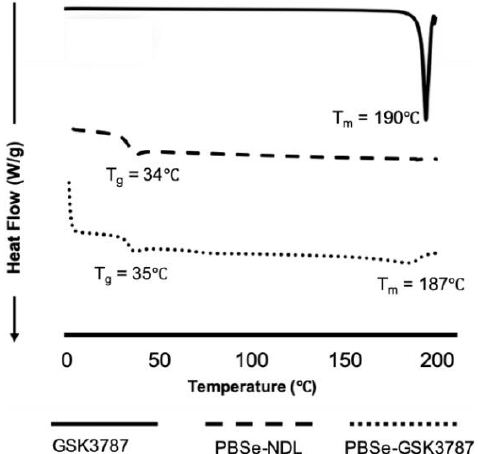
Figure 3. Differential scanning calorimetry (DSC) of GSK3787, PBSe-NDL, and PBSe-GSK3787. DSC shows a T m for the drug and for phase separated drug in the particles. Particles both with and without drug had very similar T g values, again suggesting phase separation of the drug in the particles.